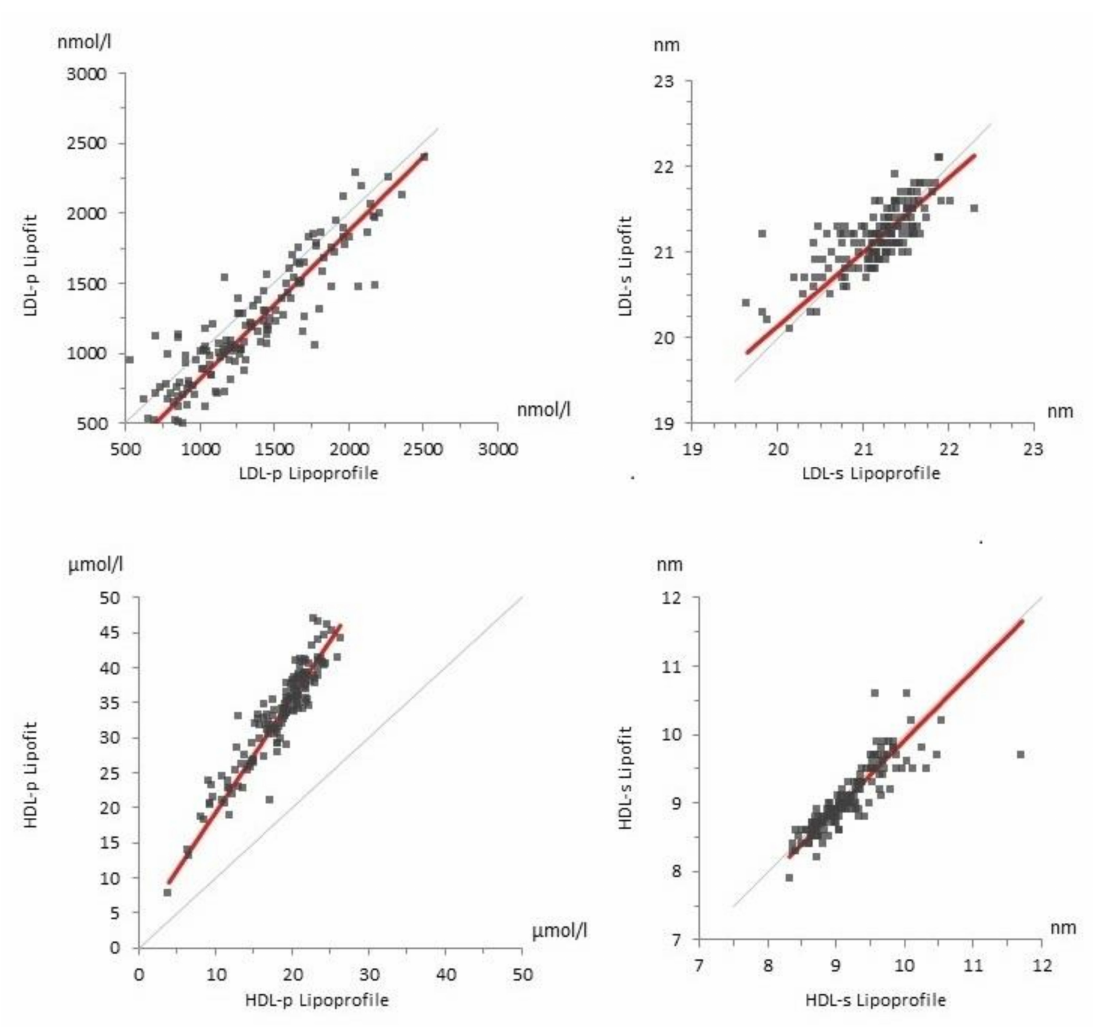
Figure 2. Comparison of lipoprotein particles between the lipoprofile NMR and lipofit NMR methods. The figures show the Passing–Bablok regression for LDL-p (top left ), LDL-s (top right), HDL-p (bottom left, and HDL-s (bottom right ). The respective slopes of the regression lines (red) were 1.057 (LDL-p), 0.860 (LDL-s), 1.637 (HDL-p), and 1.014 (HDL-s), respectively. The grey line represents the line of identity. (HDL = high-density lipoproteins. LDL = low-density lipoproteins. p = particles. s =